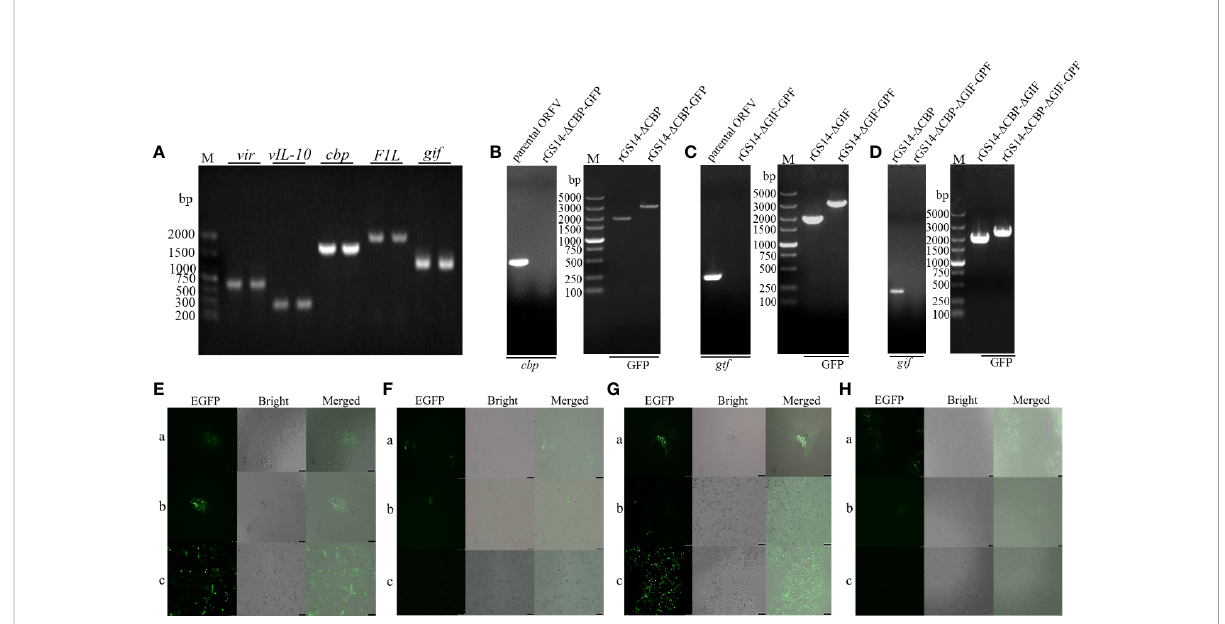
FIGURE 2 Construction of Diagram of gene-deletion recombinant ORFV. (A) Agarose gel demonstrating PCR ampli fi cation of the main conservative gene and virulent genes from the genome of the parental ORFV-GS14. (B) Representative agarose gel demonstrating the deletion of cbp gene from parental ORFV-GS14 and the generation of rGS14- D CBP. (C) The same experiments for the recombinant viruses rGS14- D GIF and (D) rGS14- D CBP- D GIF. (E) Plaque puri fi cation of rGS14- D CBP-GFP. a: the fi rst round of plaque puri fi cation, b: the third round of plaque puri fi cation, c: the sixth round of plaque puri fi cation. (F) Plaque puri fi cation of rGS14- D CBP. a: the second round of of plaque puri fi cation, b: the third round of plaque puri fi cation, c: the fourth round of plaque puri fi cation. (G, H) the same experiments for the recombinant viruses rGS14- D CBP- D GIF-GFP and rGS14- D CBP- D